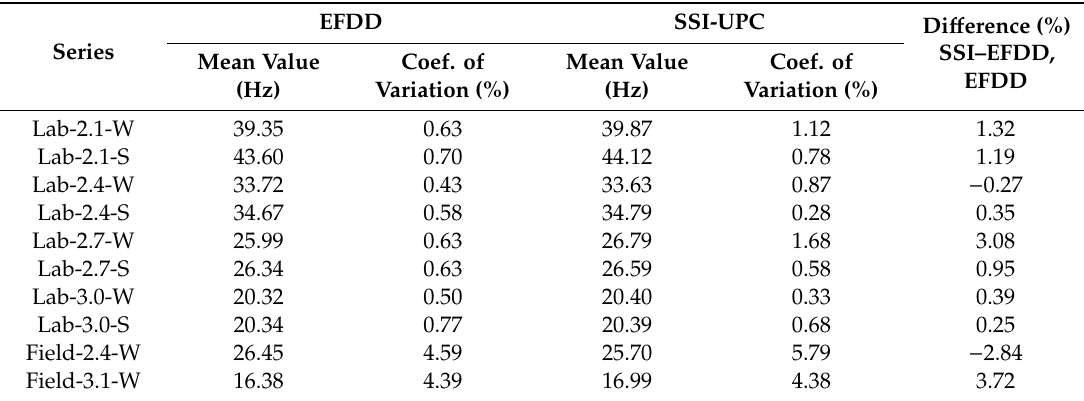
Table 5. Fundamental frequencies for laboratory and in-situ timber